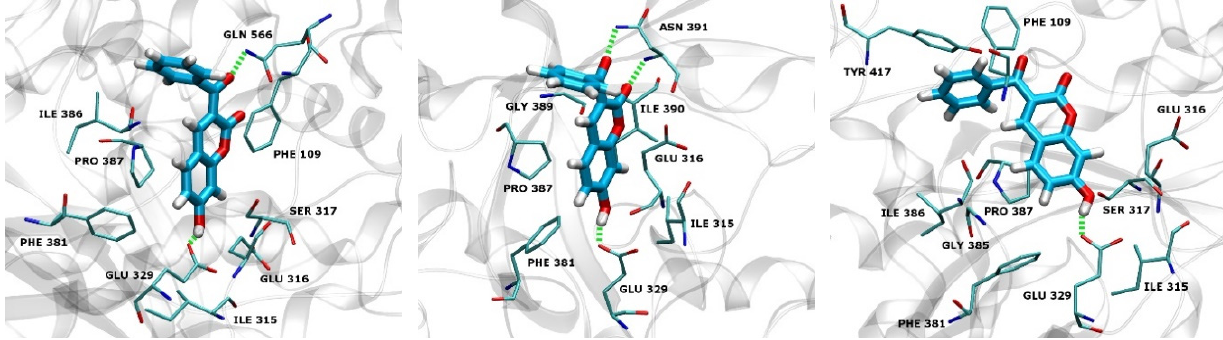
Figure 8. hDPP III residues involved in native contacts and H-bond formation with compound 12 for run 1 ( left ), run 2 ( middle ) and run 3 ( right ). H-bonds are depicted as green dashed lines, and compound 12 as light blue sticks.